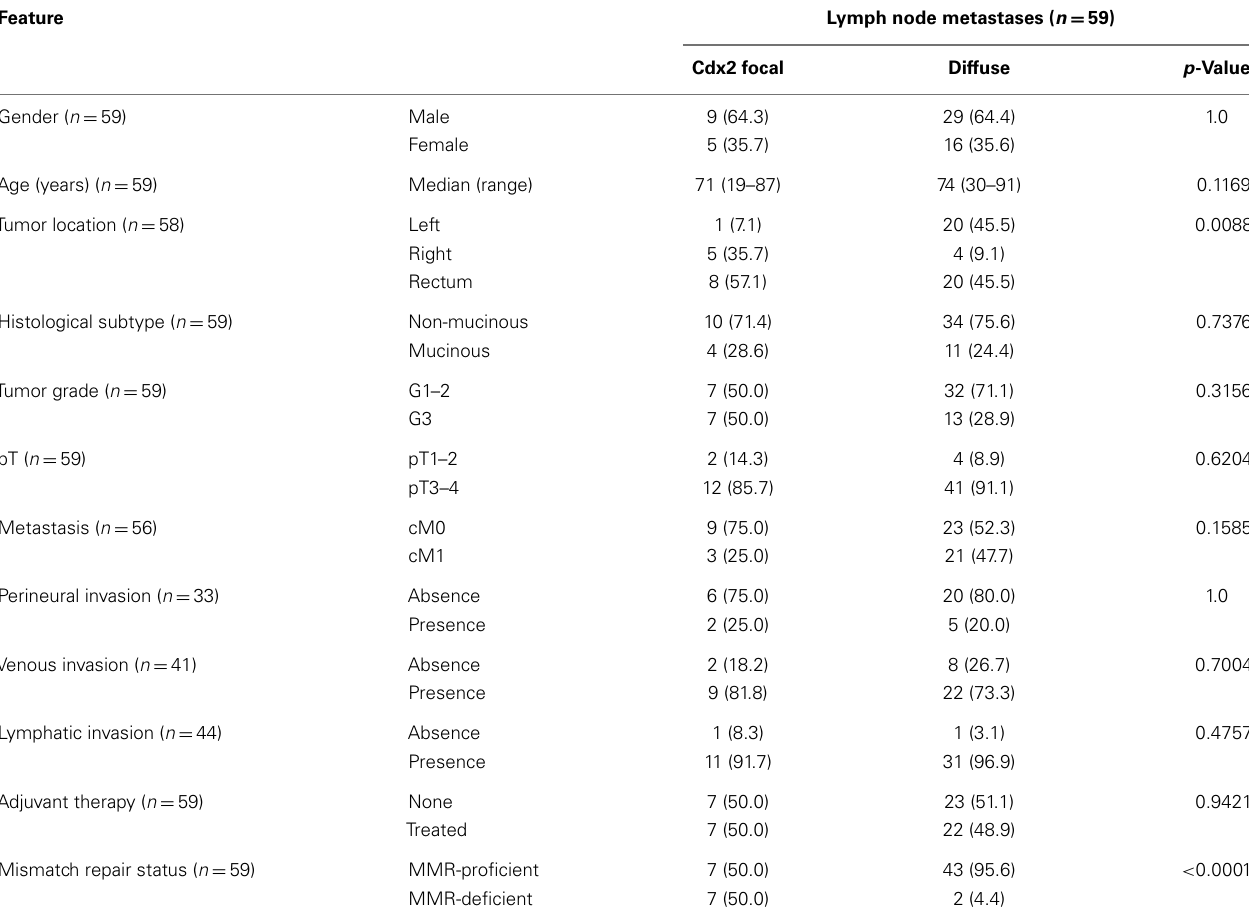
Table 2 |Association of Cdx2 loss in tumor and lymph nodes with clinicopathological features ( n = 59).